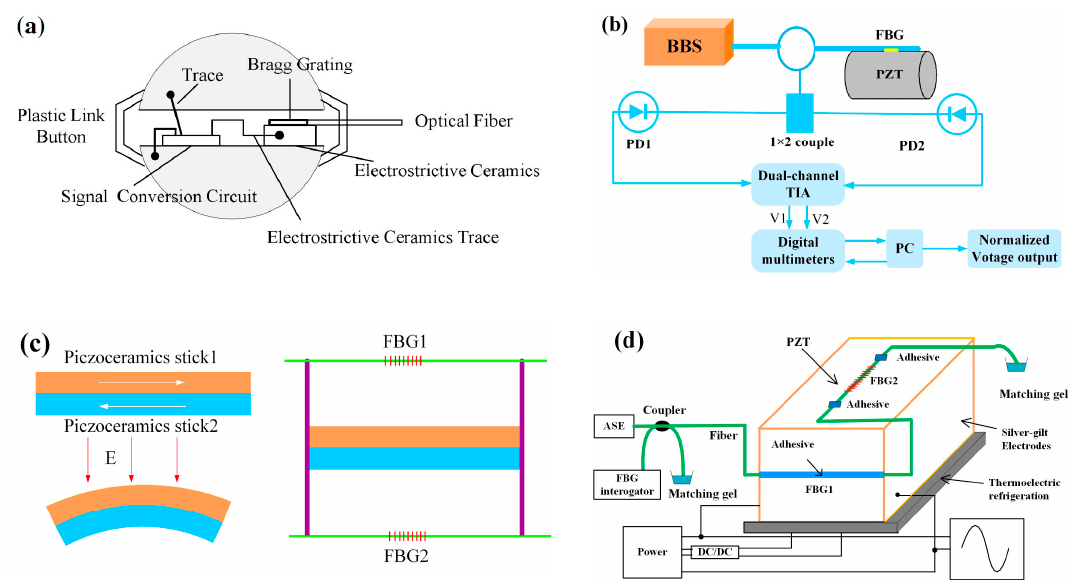
Figure 15. ( a ) Electric field sensor probe based on electrostrictive ceramics [106], ( b ) sensing system based on FBG bonded to a piezoelectric ceramic (PZT) cylinder [107], ( c ) sensing probe configuration of two FBGs and piezoceramics [108], ( d ) sensing system with high sensitivity using two FBGs glued on piezoceramics with different direction [109].